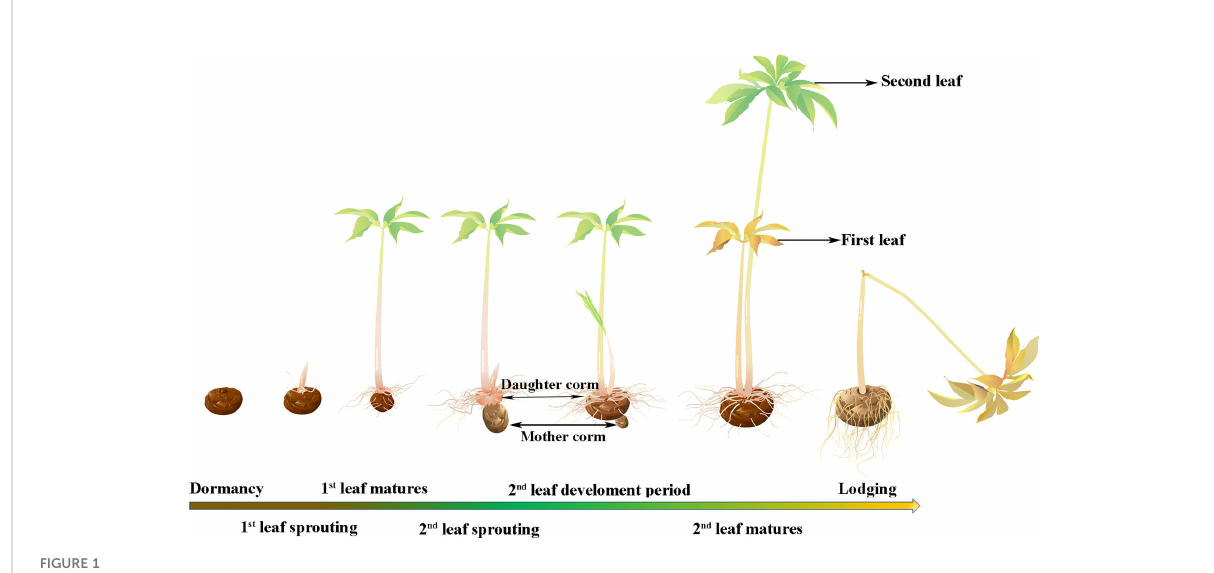
FIGURE 1 Schematic representation of the multileaf growth pattern of A. muelleri